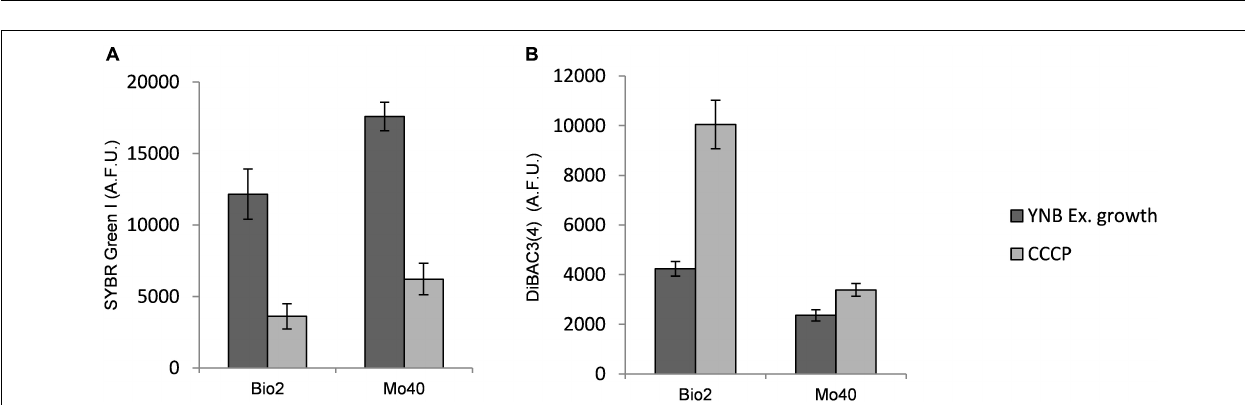
FIGURE 4 | Quantitative analysis of (A) SYBR Green I and (B) DiBAC 4 (3) fluorescences detected by FMC after exposure to hypo-osmotic stress for 30 min. AFU, Arbitrary Fluorescence Units.